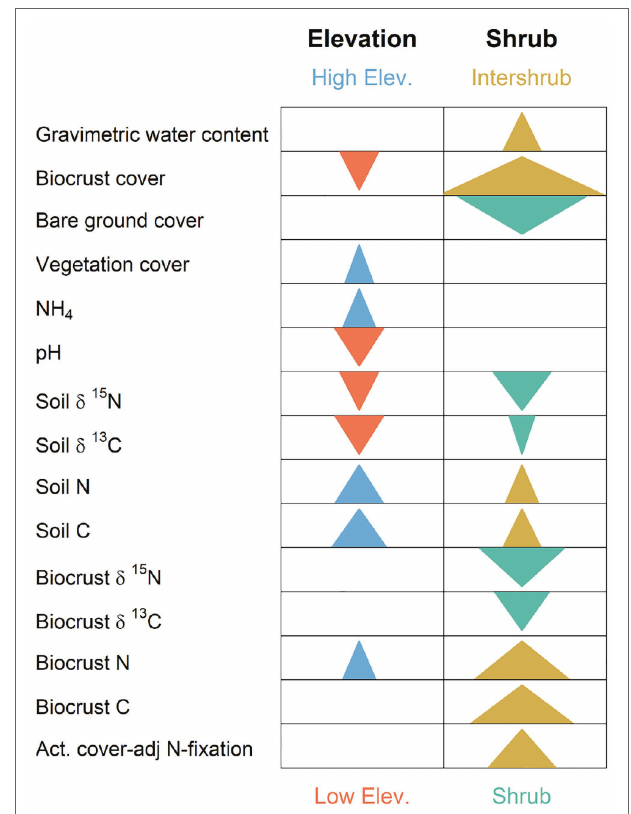
FIGURE 3 | Graphical summary of significant split-split-plot analyses (or in the absence of date replication), split-plot analyses for biocrust, and soil biogeochemistry response variables. Arrows indicate that statistically significant main effects occurred for elevation or shrub presence/absence in a mixed model along with an absence of significant interactions with other factors (see Supplementary Table S1 ). Arrows point in direction of significant numeric increase. Arrow width is scaled by the log of the inverse p . Thus, wider arrows denote smaller values of p , and indicate more dramatic